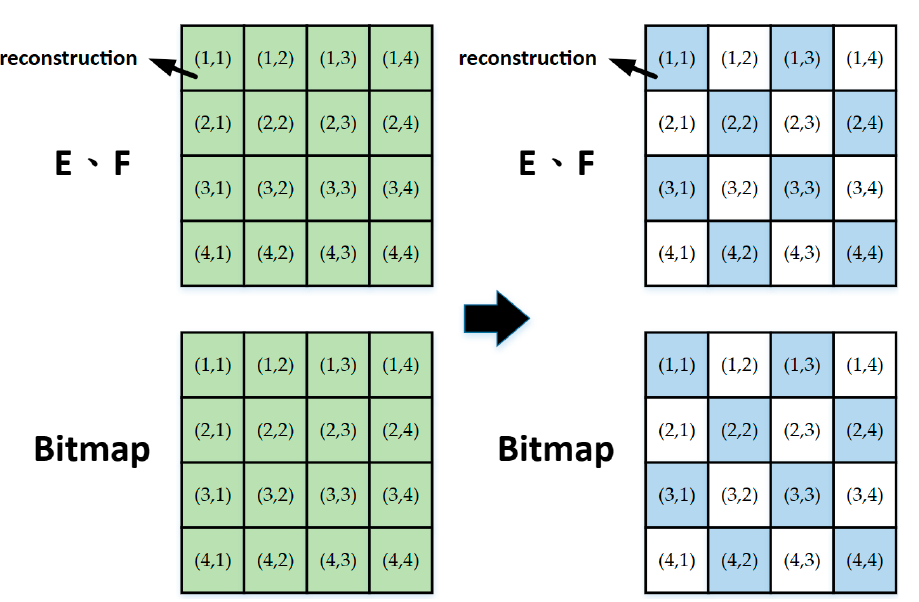
Figure 5. The 4:2:2 sampling of the reconstruction value and bitmap. Table 1. Quantization table for the encoder and decoder.